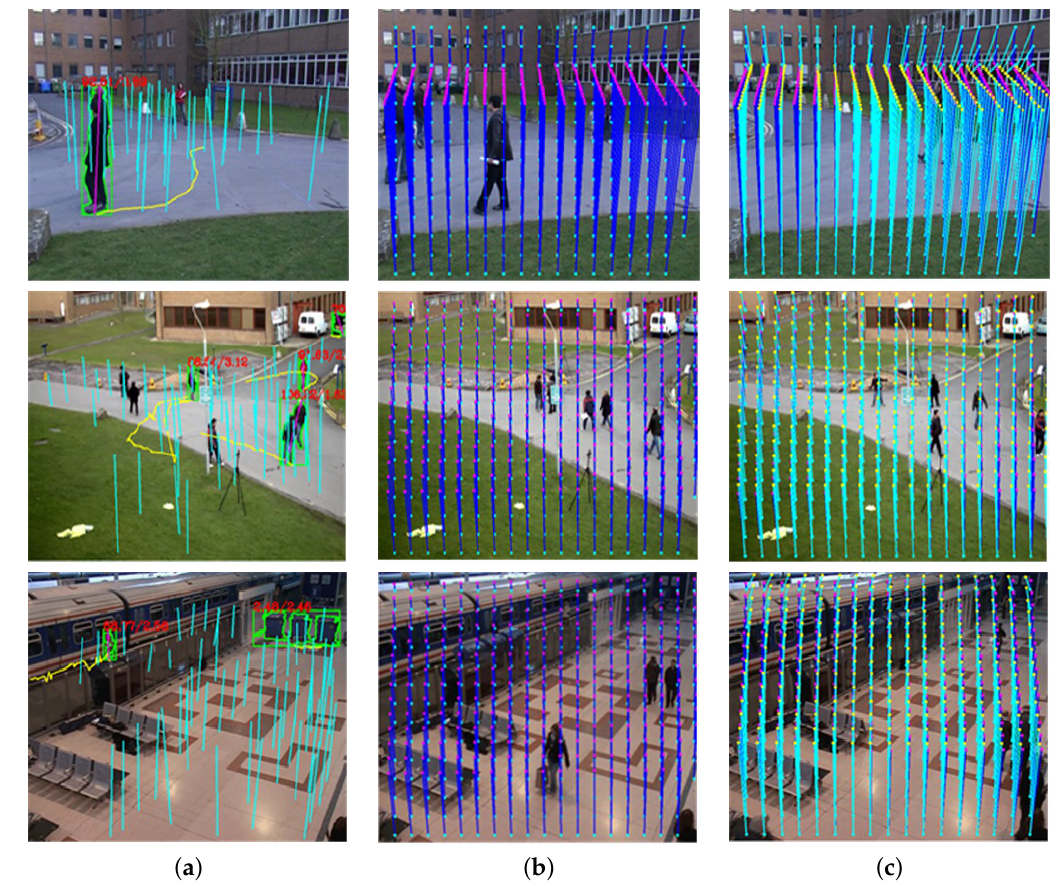
Figure 6. Foot-to-head homology estimation: ( a ) inlier data; ( b ) ground truth of the homology; and ( c ) the estimated